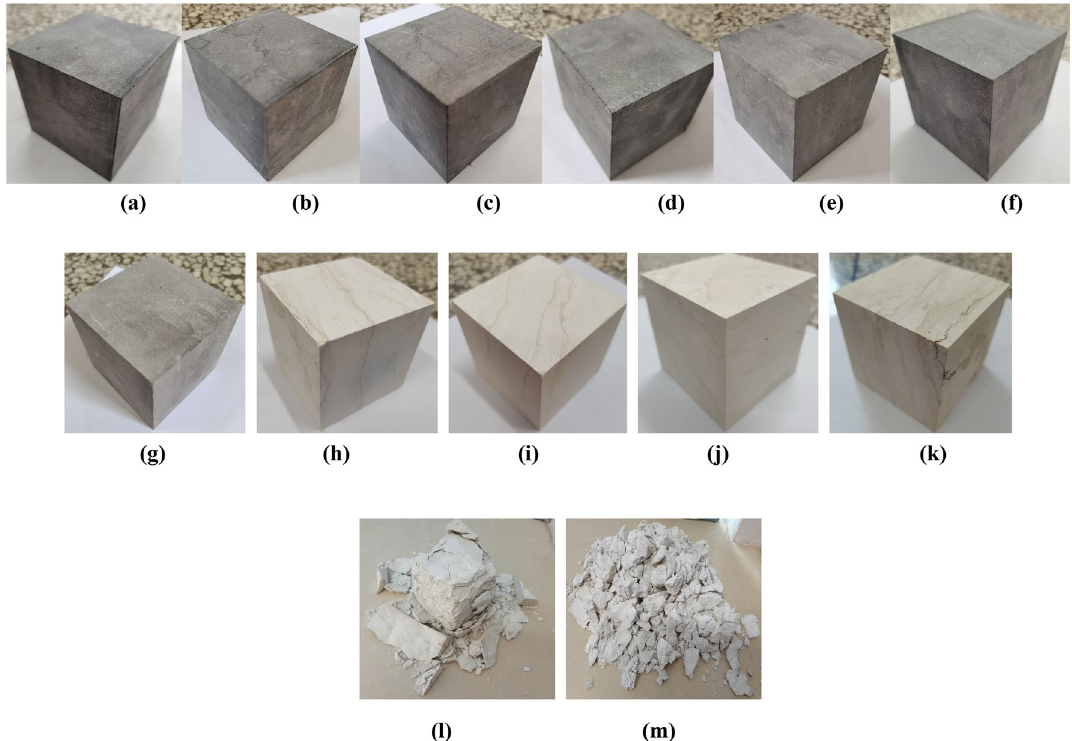
Figure 2. Apparent morphology of limestone samples after high-temperature treatment: ( a ) 25 °C; ( b ) 100 °C; ( c ) 200 °C; ( d ) 300 °C; ( e ) 400 °C; ( f ) 500 °C; ( g ) 600 °C; ( h ) 700 °C; ( i ) 800 °C; ( j ) 900 °C; ( k ) 1000 °C; ( l ) 1000 °C-72 h; ( m ) 1000 °C-120